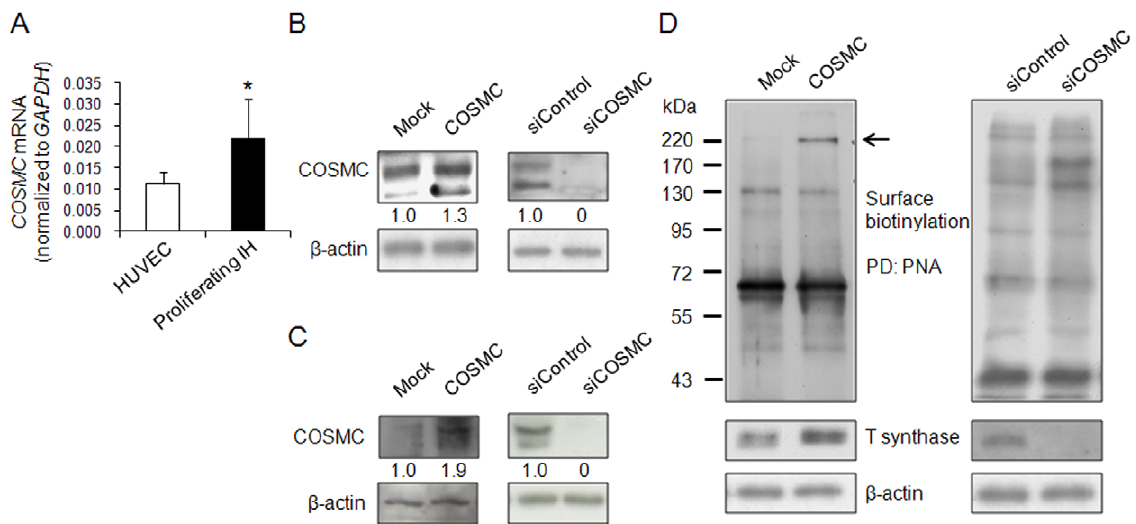
Figure 2. Expression of COMSC in HUVECs and EA.hy926 cells. (A) Proliferating infantile hemangiomas (IHs) (n=3 patients) express higher levels of COSMC than HUVECs (n=3 batches). COSMC mRNA levels were analyzed by real-time RT-PCR. * P , 0.05. In lower panel, COSMC is overexpressed in HUVECs. (B) Western blots showing COSMC overexpression (left panel) and knockdown (right panel) in HUVECs. b -actin is a loading control. Relative intensity of signals on Western blots was quantified by ImageQuant5.1. (C) COSMC overexpression and knockdown in human endothelial cell line EA.hy926. Relative intensity of signals on Western blots was quantified by ImageQuant5.1. (D) COSMC overexpression and knockdown modulate cell surface carbohydrates on HUVECs. Left panel, COSMC overexpression enhances T synthase and T antigen expression in HUVECs. HUVECs were cell surface biotinylated, lysed, pulled down (PD) with PNA, and then blotted with streptavidin-HRP. The arrow indicated that a protein band with molecular mass of 220-kDa has increased PNA binding in COSMC-transfected HUVECs. Cell lysates were Western blotted for detecting T synthase expression and b -actin was used as a loading control. Right panel, COSMC knockdown increased glycoproteins pulled down by VVA, which recognizes Tn antigen.